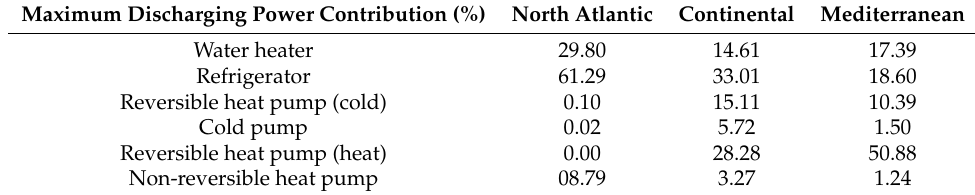
Table 9. Contribution percentage of each type of TCL to maximum discharging power per climate area in